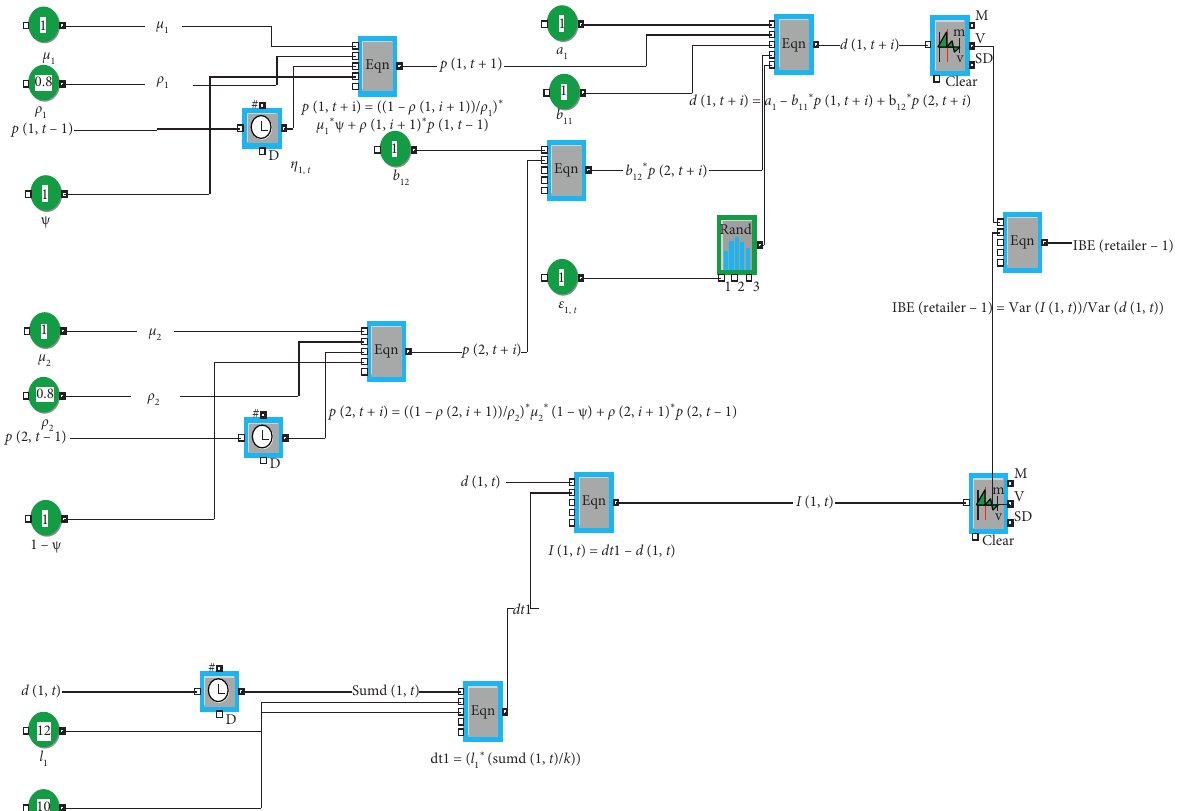
(retailer – 1) = Var ( I (1, t ))/Var ( d (1, t